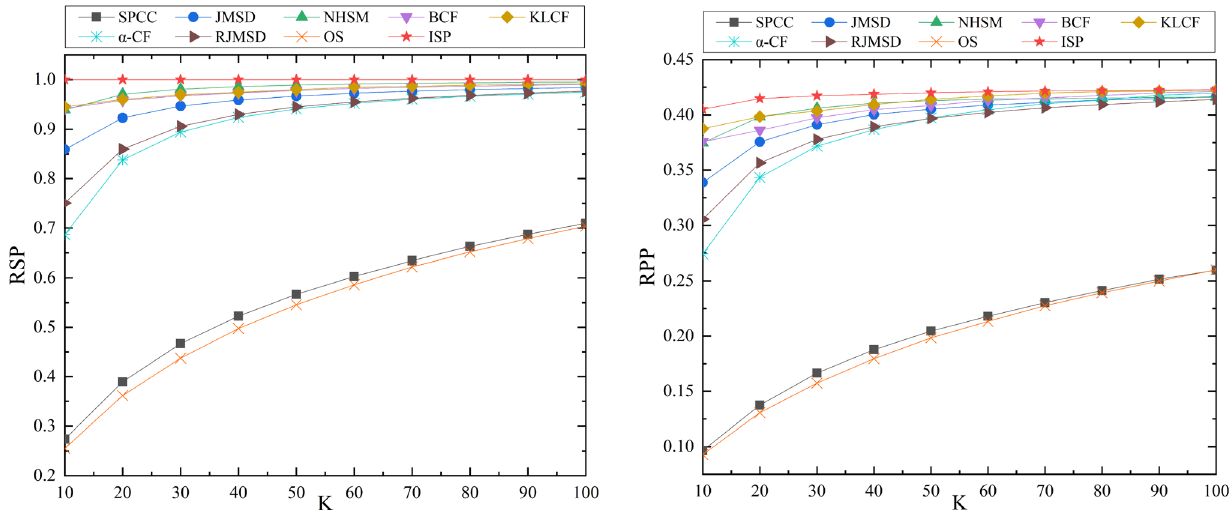
Fig. 8 RSP and RPP values of all algorithms in ML-1